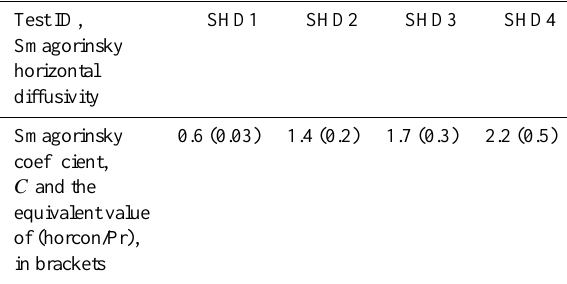
Table 1. Horizontal diffusivity